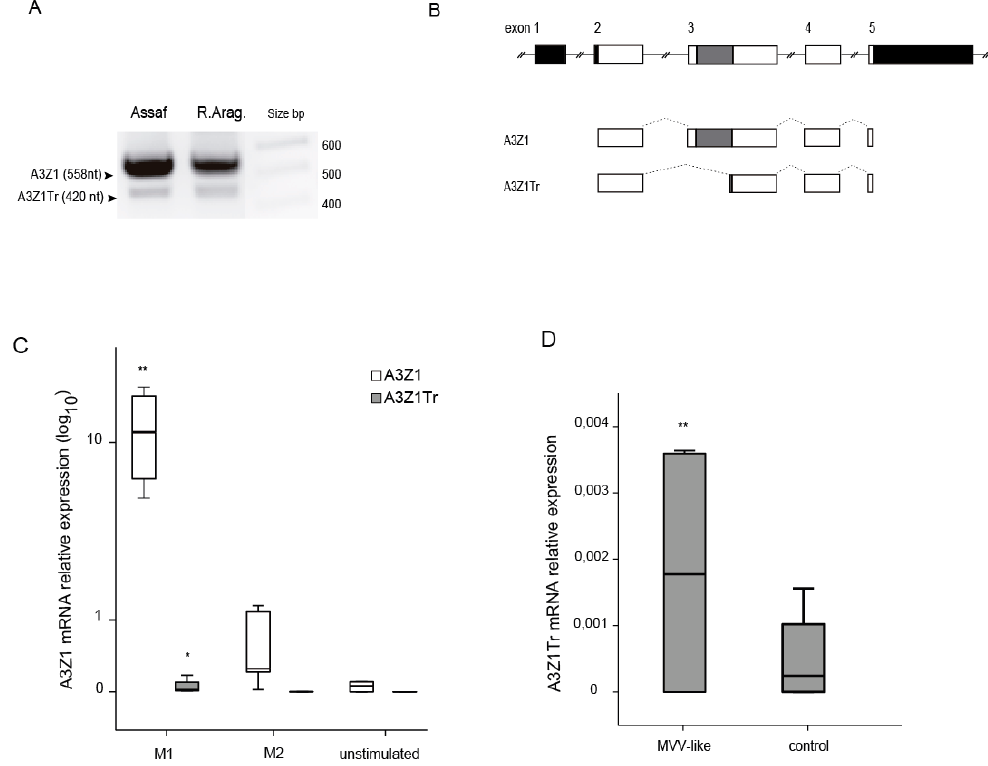
Figure 2. A3Z1 and A3Z1Tr detection. ( A ) Amplification of complete A3Z1 and the A3Z1Tr spliced variant from cDNAs samples of Assaf and Rasa Aragonesa sheep breeds; ( B ) ovine A3Z1 spliced variant diagram compared to the GenBank deposited sequence. Introns are represented by solid lines, exons by boxes and splicing sites by dotted lines. Untranslated regions, black; coding regions, white; cytidine deaminase motif, dark grey; frameshift, light grey; and dotted line boxes: no translated; ( C ) expression of A3Z1 and A3Z1Tr (2 −Δ C t × 100) in BDM treated with IFN- γ , IL-4 or pN3- control for 6 days; ( D ) relative expression of A3Z1Tr (2 − ∆ C t × 100) in BDM infected with SRLVs from